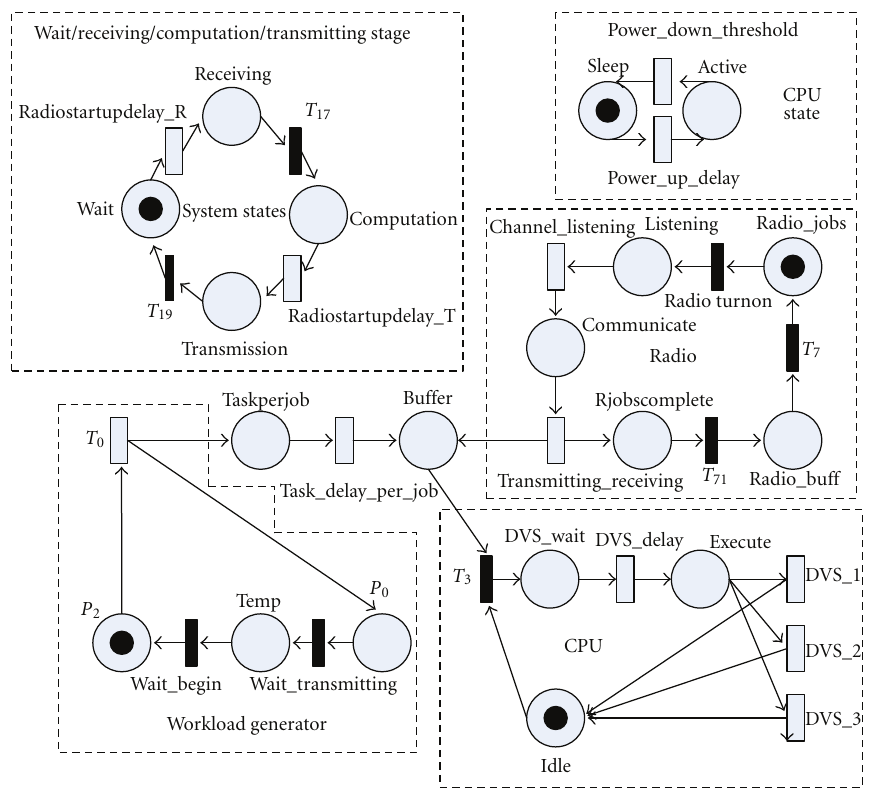
Figure 13: Closed system model of node in wireless sensor